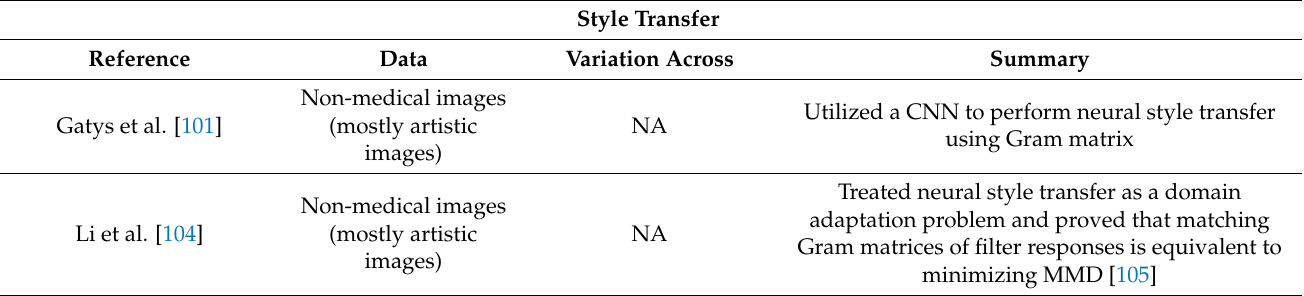
Table 4. Summary table of style transfer